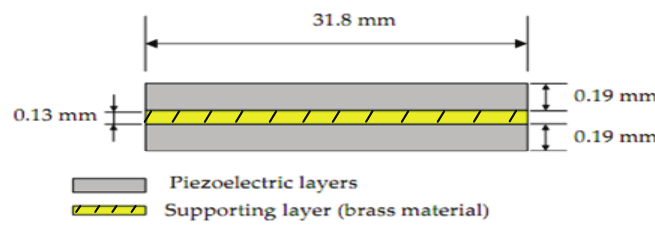
Figure 3. Cross sectional area of the used bimorph